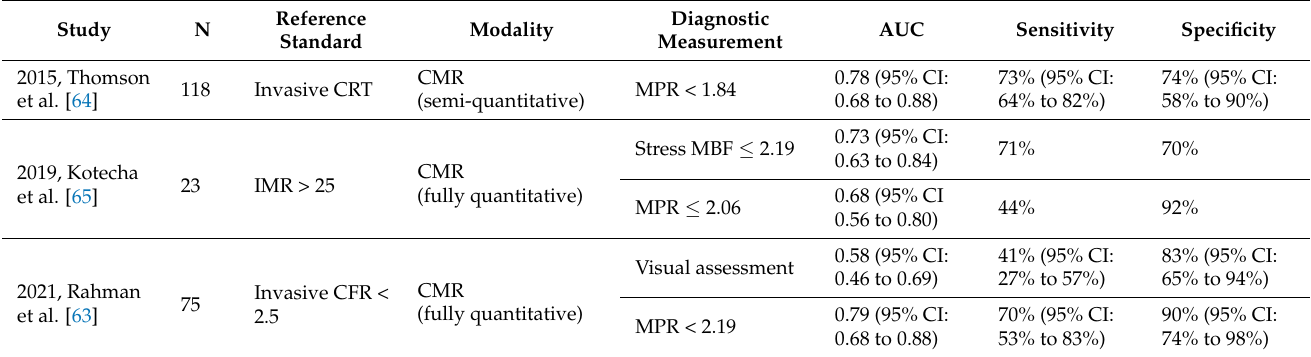
Table 1. Semi-quantitative and fully quantitative diagnostic thresholds of stress CMR for